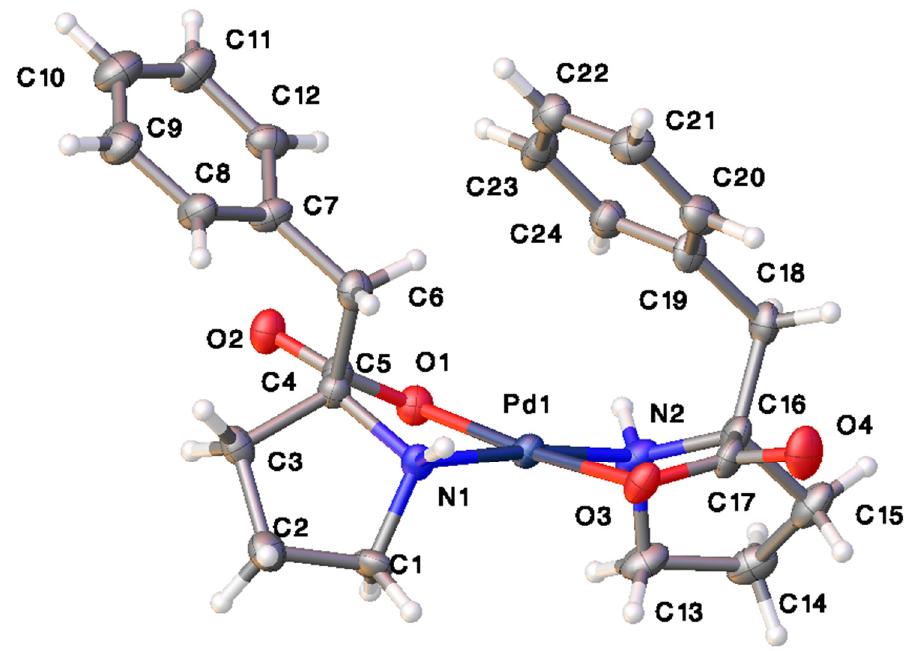
Figure 9. Thermal ellipsoid plot of the molecular structure of crystalline trans -bis-(2- benzylprolinato)palladium(II), 5 . Thermal ellipsoids are shown at the 50% probability level. CCDC:1913619.